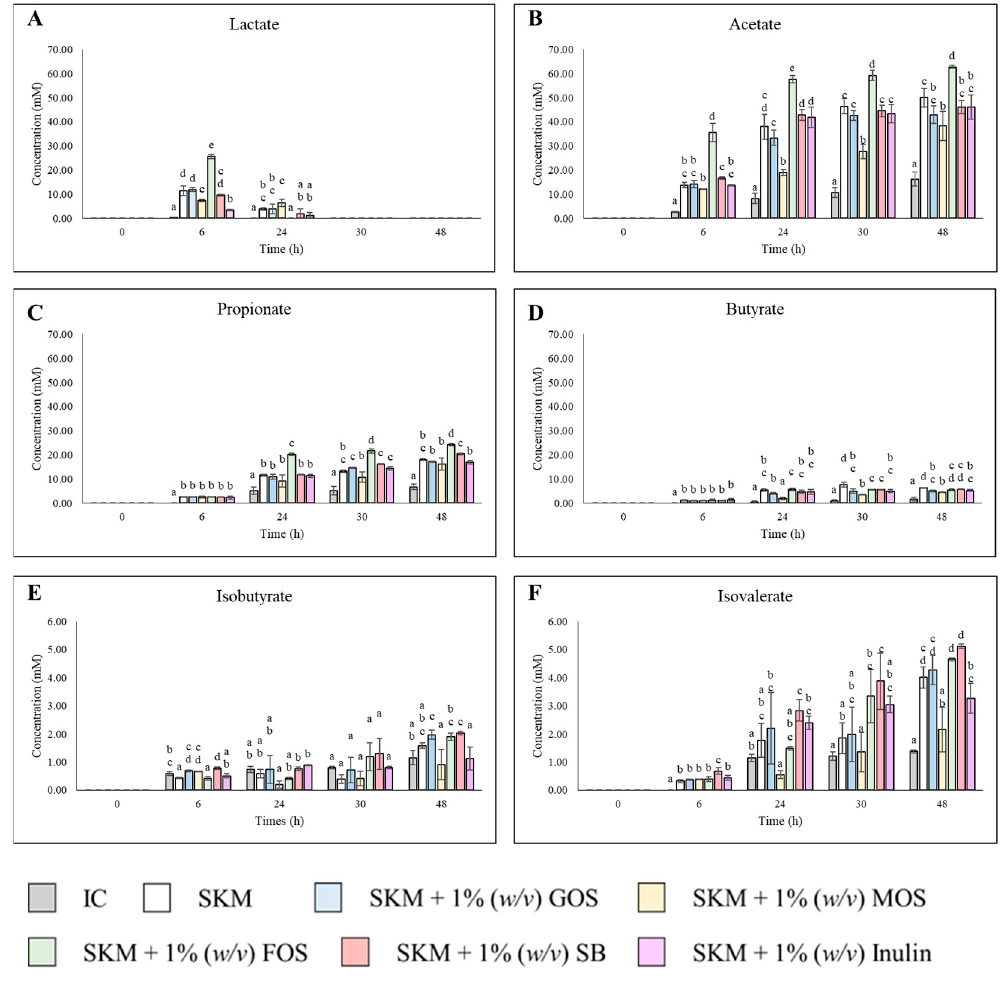
Figure 2. ( A – F )—Concentration (mM, means ± SD) of the different organic acids produced during 48 h of fecal fermentation: ( A ) lactate, ( B ) acetate, ( C ) propionate, ( D ) butyrate, ( E ) isobutyrate and ( F ) isovalerate. Different letters mark statistically significant ( p < 0.05) differences between each condition at the same sampling time. IC—inoculum control; SKM—skim milk; GOS—galacto-oligosaccharide; MOS—mannan-oligosaccharides; FOS—fructo-oligosaccharides; SB— S. boulardii .